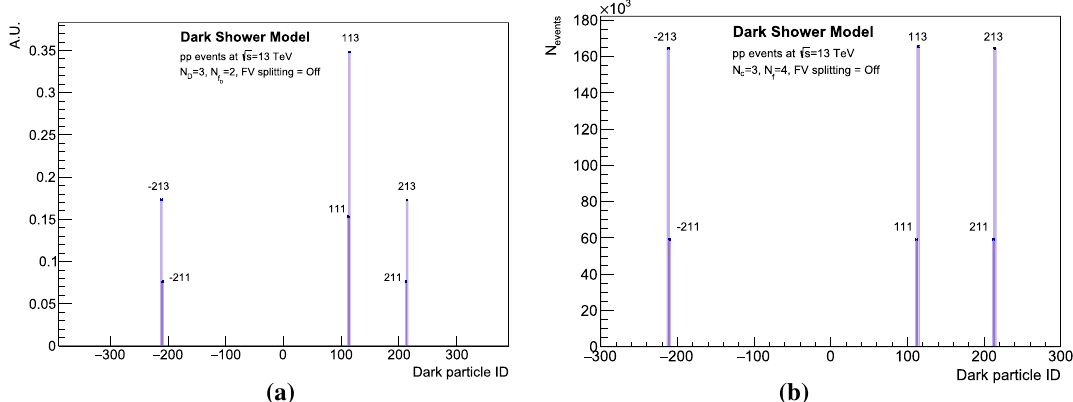
= 2 model and b N = 3 model. FV splitting is turned f D D